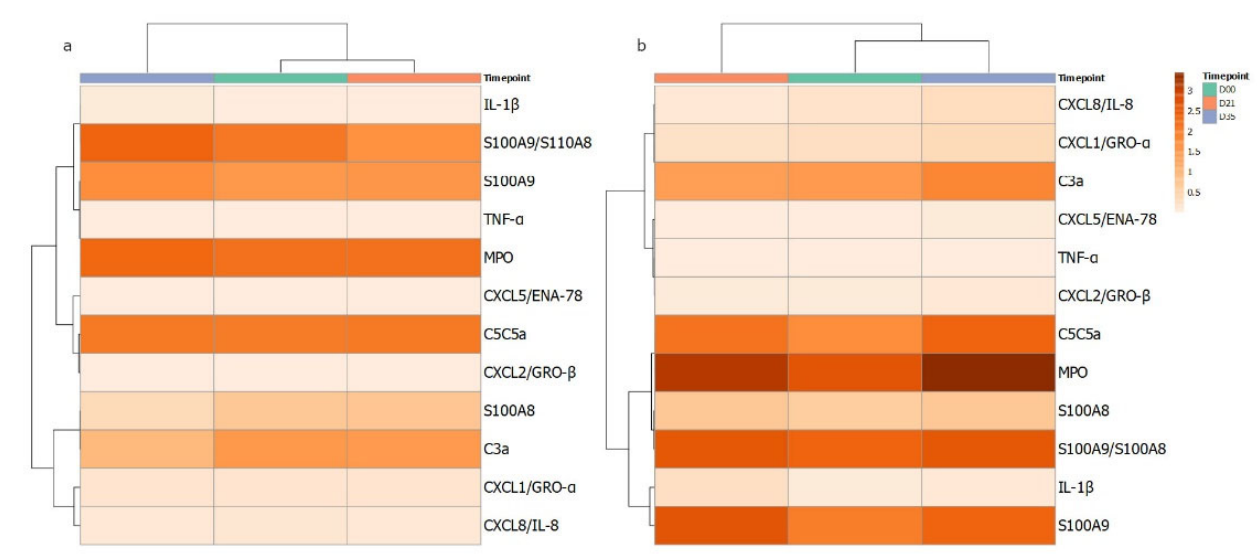
Figure 2. Heatmap of cytokines quantified from GCF samples in gingivitis. Measured mediators were grouped according to correlations in changes over the course of the 35 days. The darker the orange colour reflects higher level of the corresponding measured host mediator for ( a ) control and ( b ) test GCF collection sites at day 0, 21 and 35.